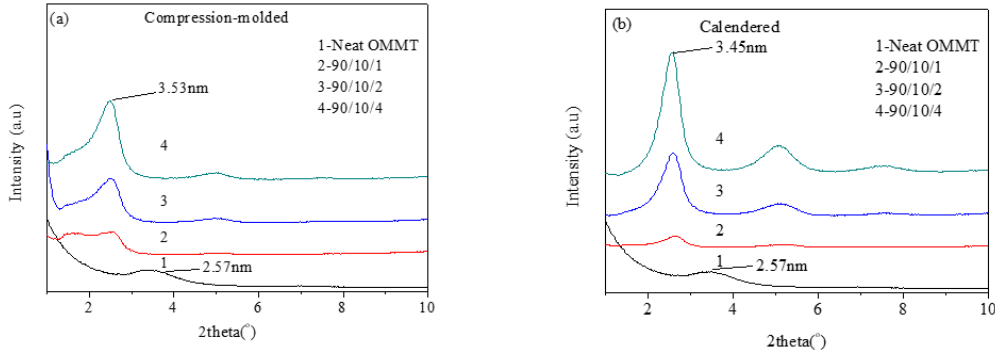
Figure 9. XRD patterns of PLLA and PLLA / EPDM / OMMT (90 / 10 / x ) samples prepared by ( a ) compression-molding and ( b ) calendering.